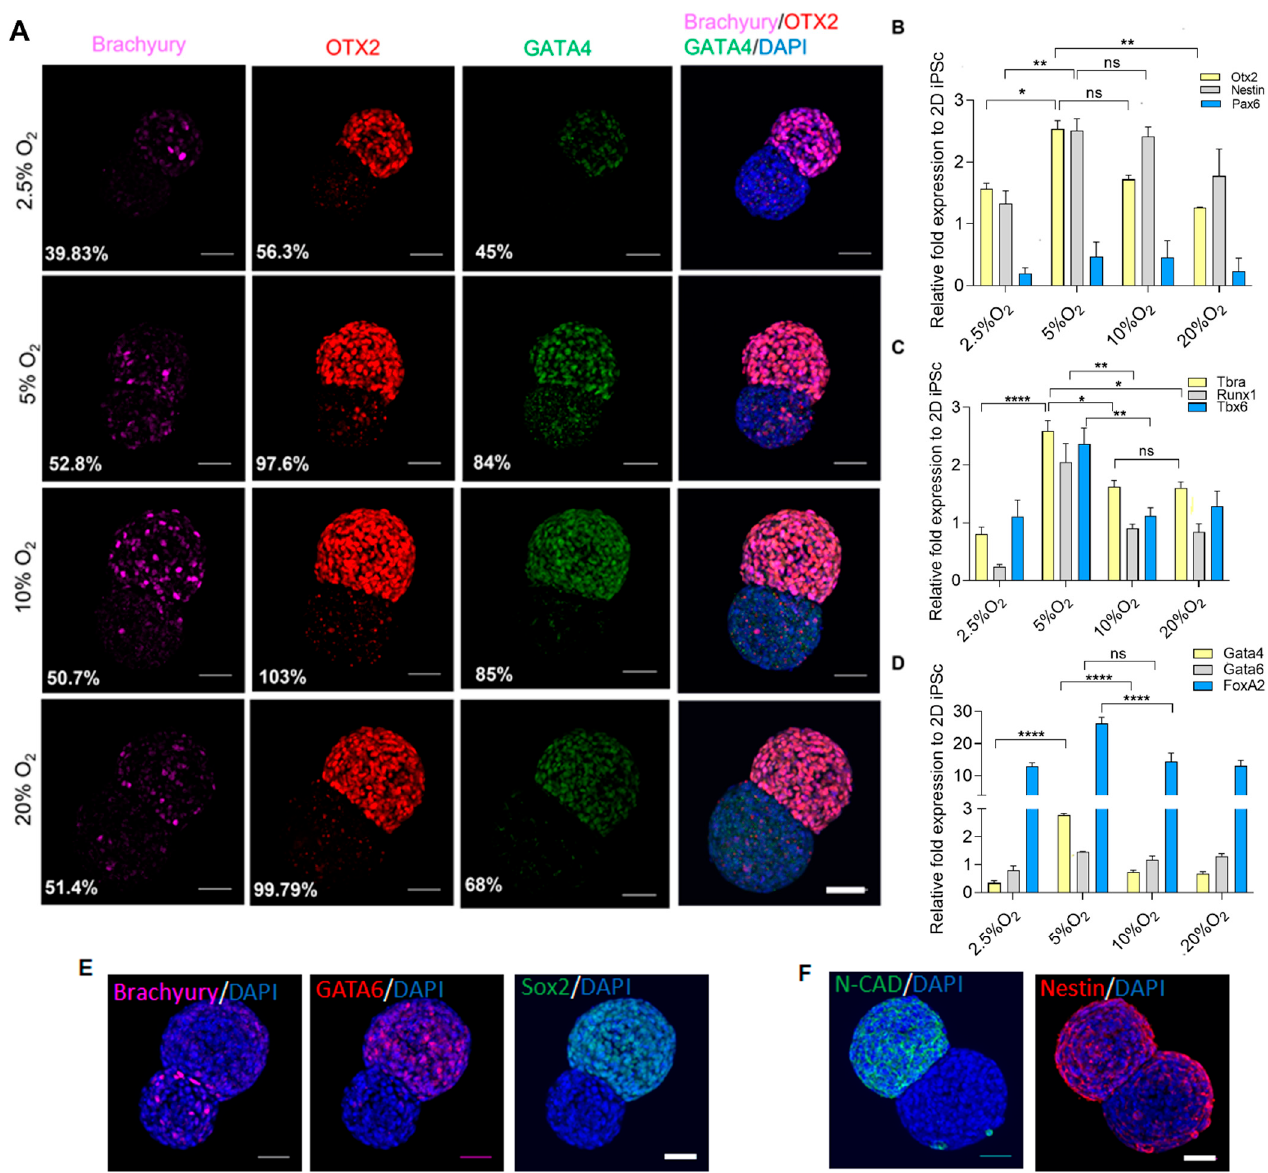
Figure 5. Gene expression of three lineages versus oxygen. ( A ) Comparison of three germ expression markers by immunocytochemistry between 2.5% to 20% O 2 , scale bar 50 µm. ( B ) Gene expression of ectodermal, ( C ) mesodermal, and ( D ) endodermal markers. ( E ) Aggregates grown at 5% O 2 from Day 5 showing co-expression of GATA6 and Sox2, and segregated Brachyury; ( F ) Expression of N-CAD and Nestin. Scale bar, 50 µm. Statistical analysis was performed with one-way ANOVA/Tukey’s test. * p < 0.05, ** p < 0.01, **** p < 0.0001; ns = non-significant with N = 3 sets of independent experiments.